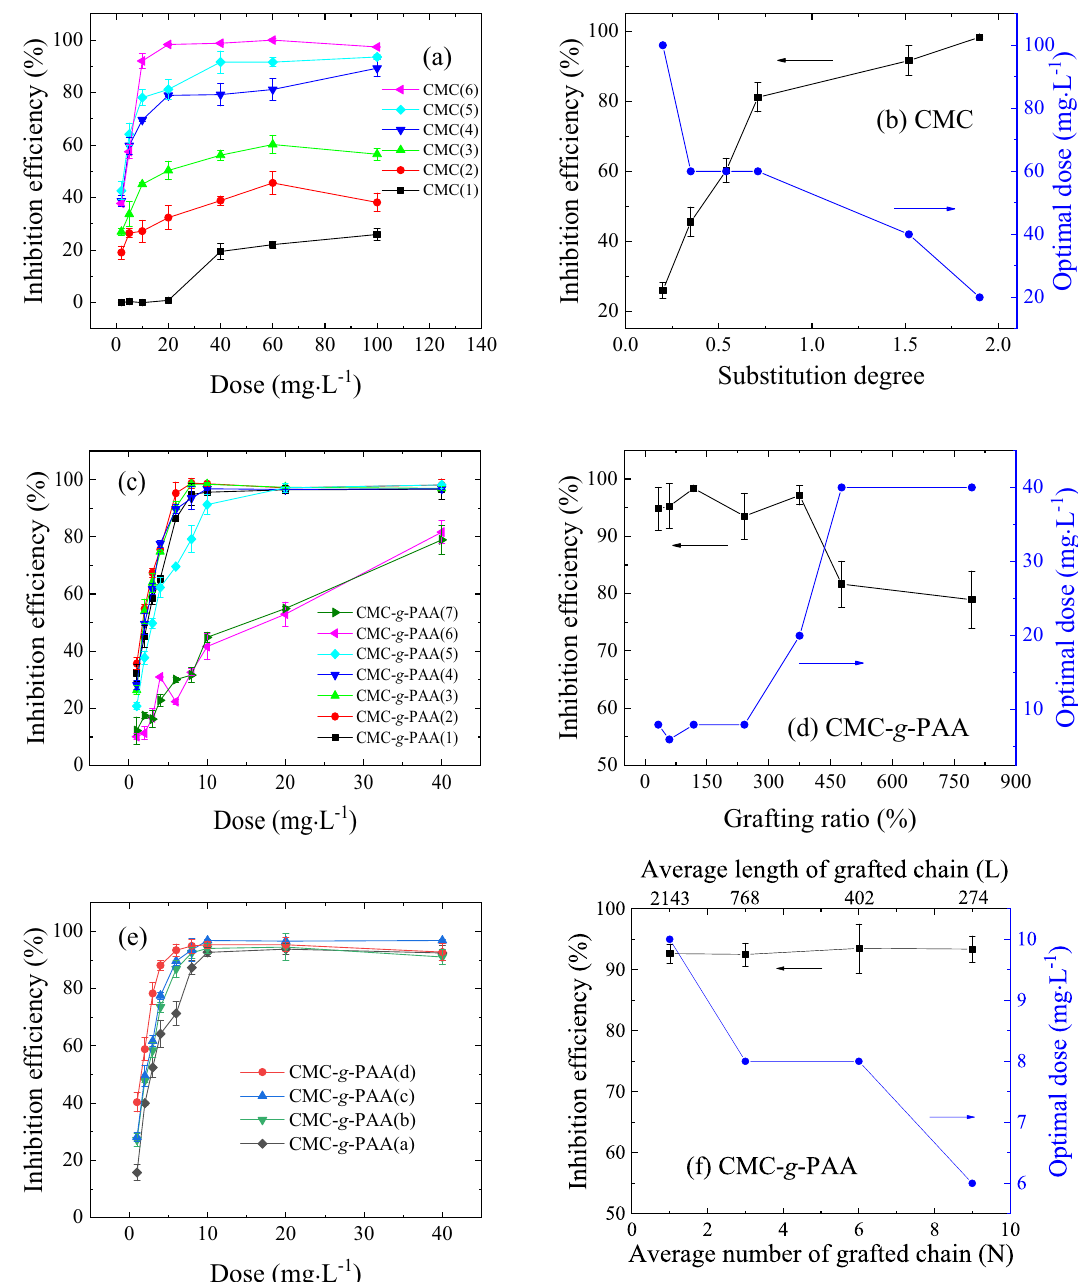
Figure 2. Effects of dose on the scale-inhibition efficiency of ( a ) different CMC and ( c , e ) various CMC- g -PAA with ( c ) different grafting ratio and ( e ) different grafted-chain distributions against CaCO 3 scale in static tests. According to ( a ), ( c ) and ( e ), the structural effects, i.e. ( b ) degrees of carboxyl substitution of CMC, ( d ) grafting ratio and ( f ) grafted-chain distribution of CMC- g -PAA, on the inhibition efficiency of these cellulose-based antiscalant against CaCO 3 scale at their optimal doses were